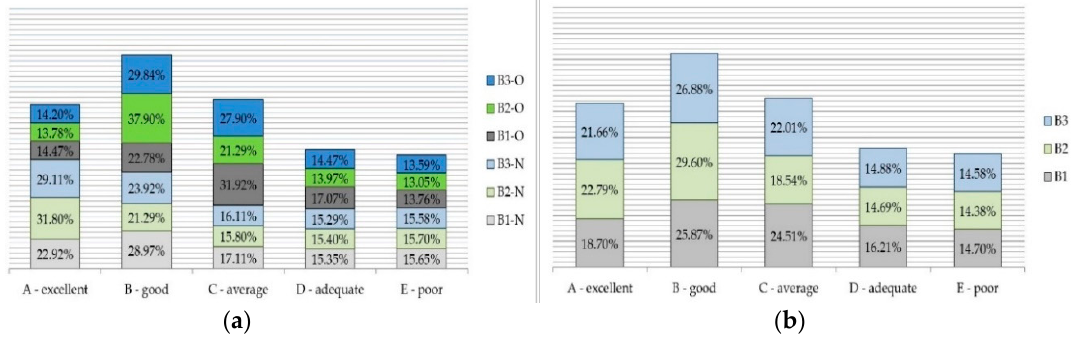
Figure 5. Comparative analysis of bulldozer availability according to different grades. ( a ) for all of the analysed machines; ( b ) for machines according to manufacturer.